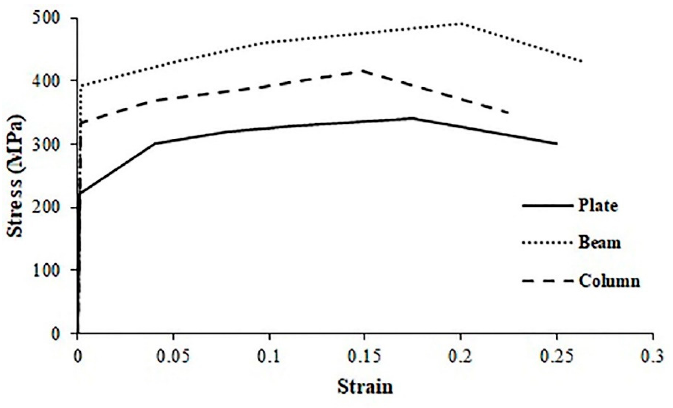
Figure 19. Stress-strain behavior of steel material.